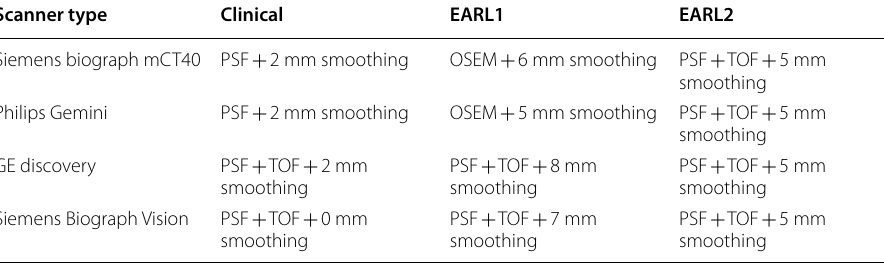
Table 1 Reconstruction settings for different scanner types Scanner